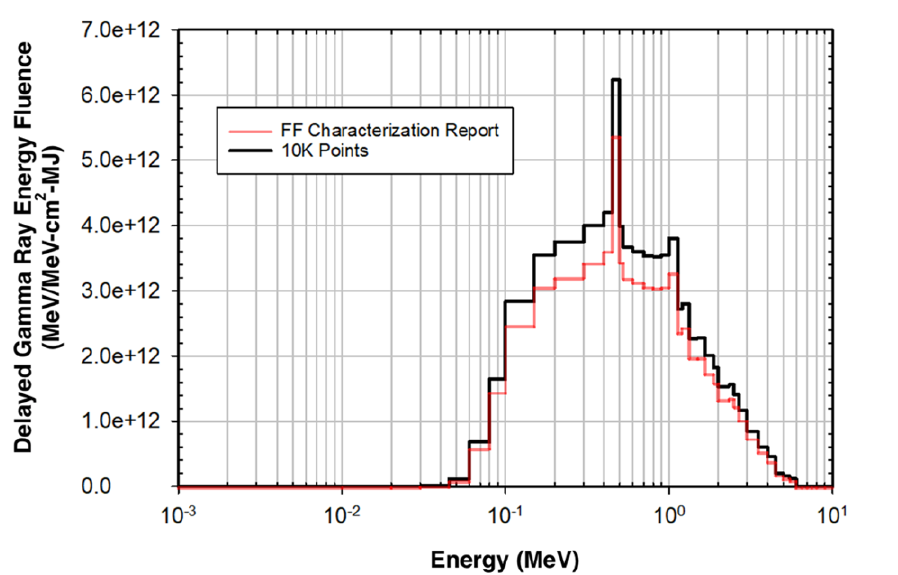
Figure 4. ACRR Free Field 10K plot versus previous report plot.